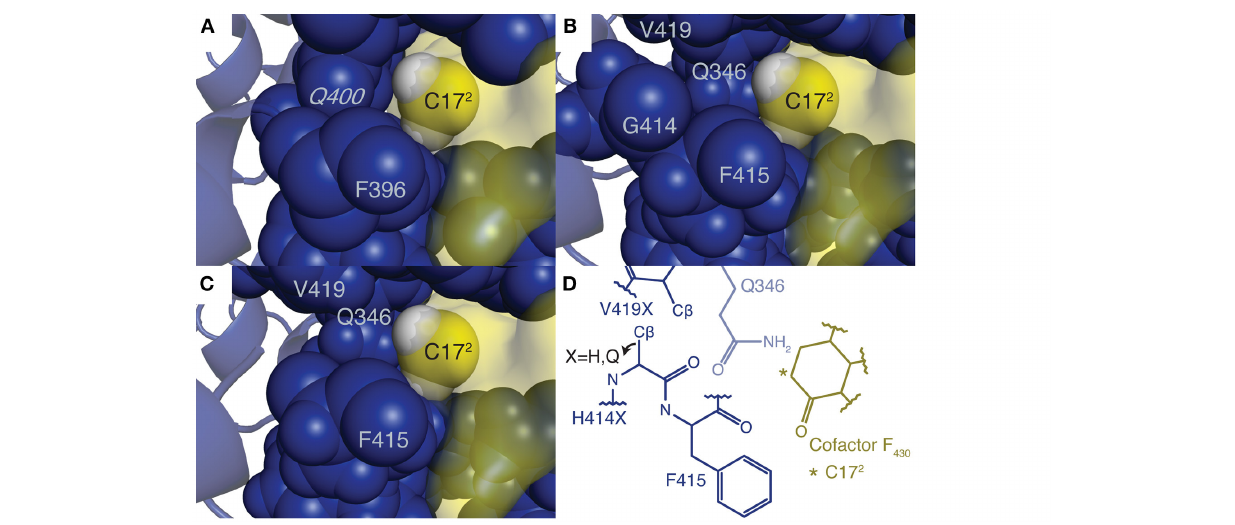
FIGURE 3 | Active site structures of (A) M. thermautotrophicus Mcr, (B) the top CS1 variant, (C) ANME-1 Mcr, and (D) an overview of all three Mcrs in complex with cofactor F 430 . In subplots (A–C) , the unmodified cofactor F 430 is depicted as a yellow molecular surface with C17 2 and its two bonded hydrogen atoms (colored white) shown as spheres. Residues within six angstroms of C17 2 are displayed as blue spheres, while the remainder of the enzyme is represented by a blue cartoon diagram. G416 and G417 (G397 and G398 in M. thermautotrophicus Mcr) are not shown so that the spatial relationship between C17 2 and nearby amino acids is clearly visible. Residues constituting the methylthio- substituent binding site in the ANME-1 structure are labeled by their one letter amino acid abbreviation and sequence position, including the methylated glutamine (italicized). The C17 2 carbon is also labeled. Due to the highly conserved structures of the three Mcrs, subplot D was created, which depicts the general architecture of the active site. Residues forming the methylthio- moiety binding site are labeled using the numbering scheme of ANME-1 Mcr (Q346, H414, F415, and V419 correspond to Q332, Q395, F396, and methyl-Q400 in M. thermautotrophicus , respectively). Q346 is behind the other the amino acids, which is represented by its reduced opacity. The position of the C β is given for the second hydrogen atom in H414G (as in the top variant of CS1), but the C β position shifts away from C17 2 if a larger side chain is